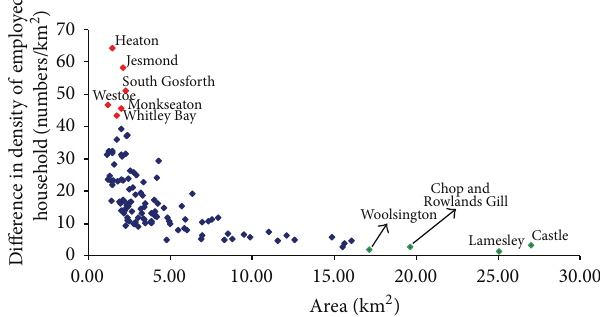
Figure 9: Forecast change in density of employed household by ward, 2008–2016. Particular changes over 40households/km 2 are highlighted by red spots, together with the ward name. The green marks, with their corresponding ward names, represent the four largest wards with little change in density of employed households from 2008 to